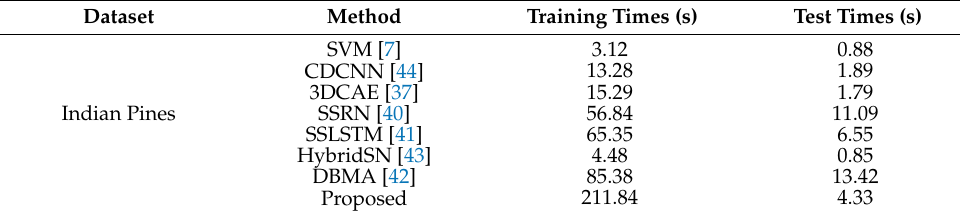
Table 11. Training and testing time on the Indian Pines dataset.